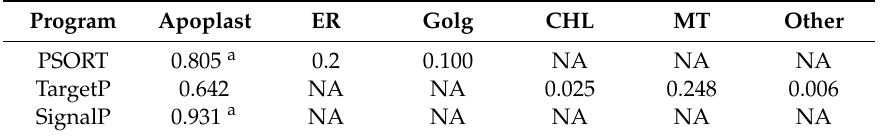
Table 1. The predicted subcellular localization of Zm-INVINH4.